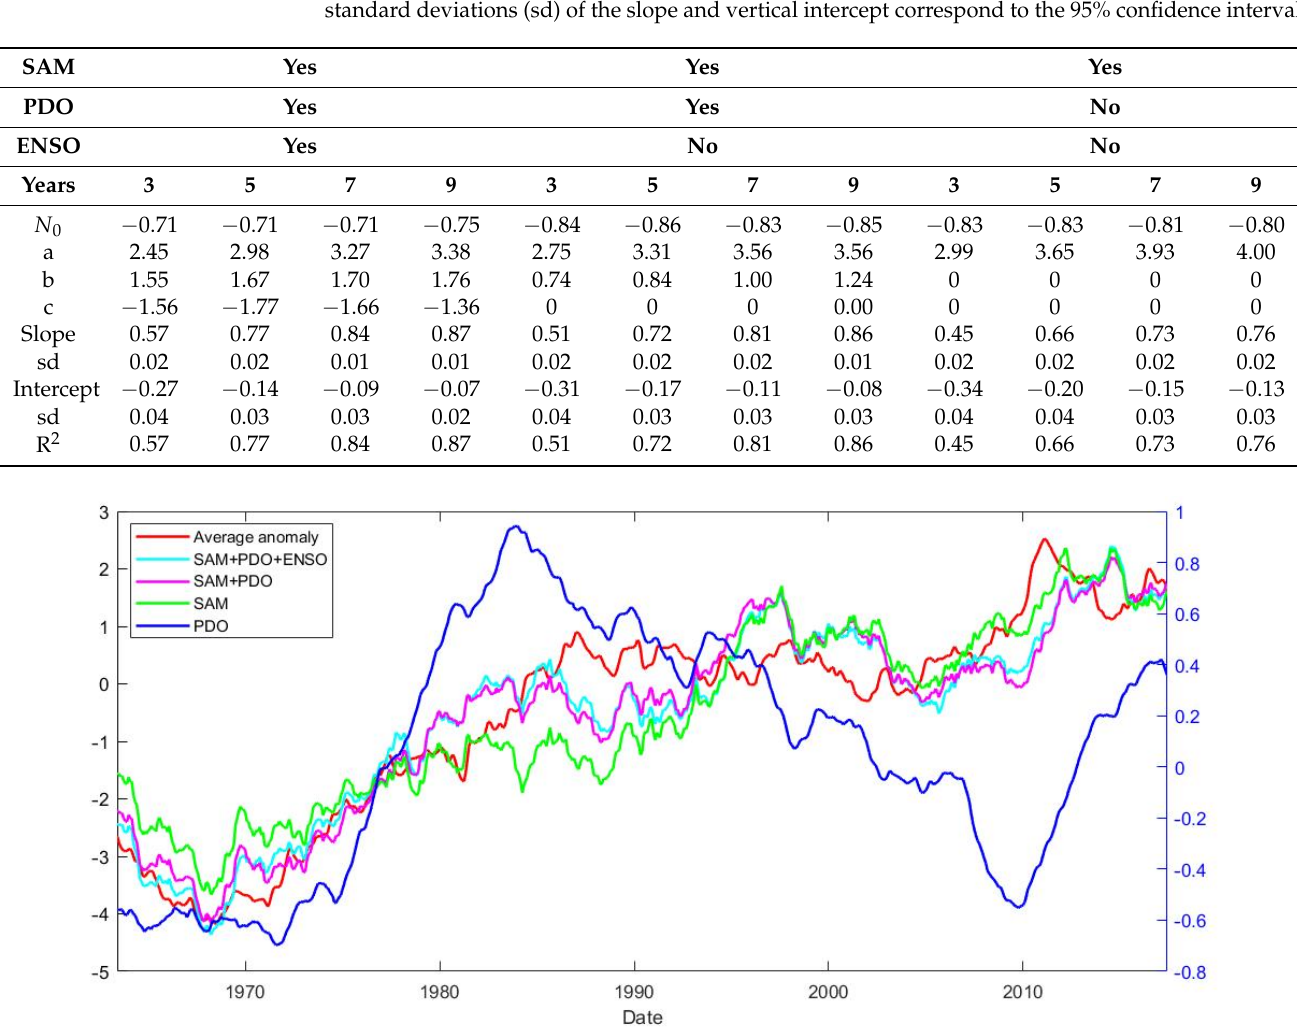
Figure 3. Temporal evolution of the ERA5 strong wind anomalies (red curve) and of the anomalies yielded by Equation (2) when taking the SAM, PDO, and ENSO effects into account (cyan line). The width of the averaging window is 9 years. For the sake of comparison, the results obtained when neglecting the ENSO (magenta line), or both the PDO and ENSO (green line) effects, are also represented. The variations of the PDO are reported in blue and its values are reported on the right vertical axis.